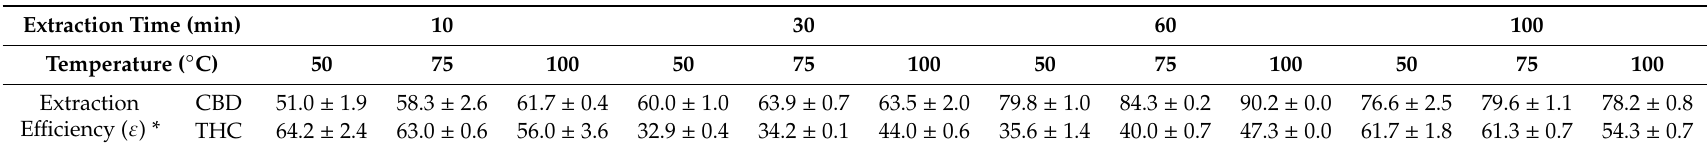
Table 5. Extraction e ffi ciency of the PLE experiments performed in the 1 L autoclave with hemp variety KC Virtus (Section 2.5, Table 1). Extraction Time